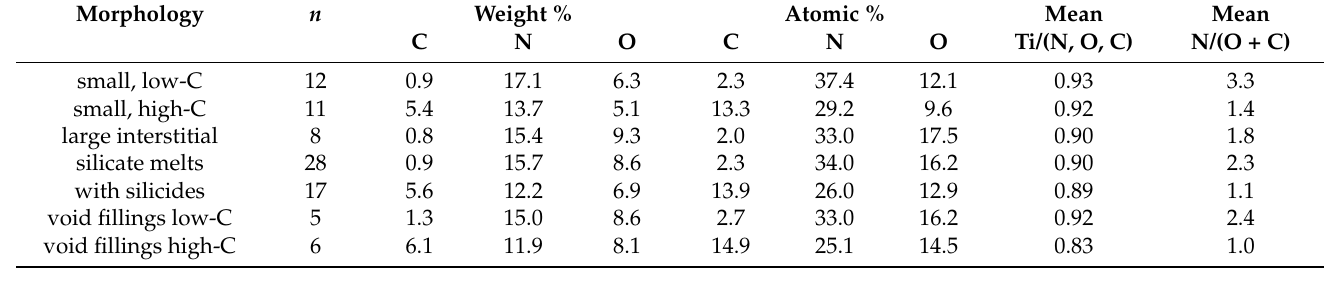
Table 1. Summary of populations.